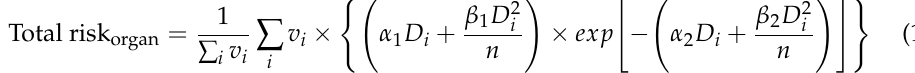
Table 1. Risk coefficients ( α 1 , second and third column) and the linear quadratic model parameter (last column) used for risk assessment for the different organs at risk.